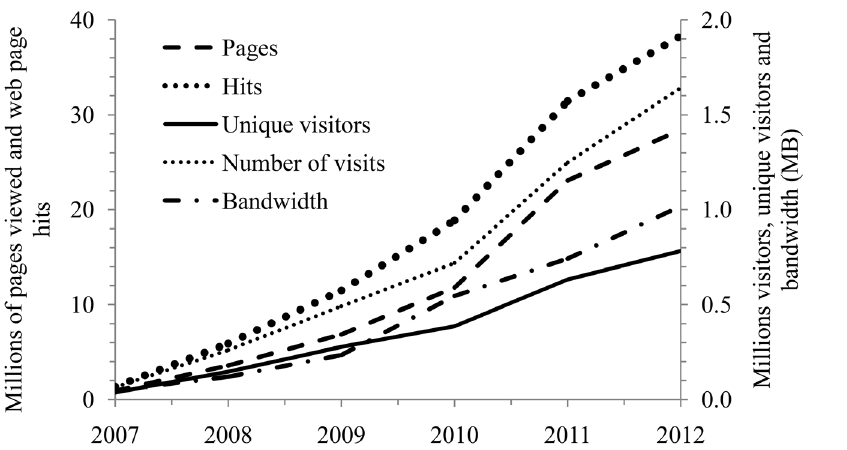
Figure 5. The annual use of the WoRMS website since January 2007 in terms of pages viewed and web page hits (left axis), and numbers of visits, unique visitors and bandwidth (MB) (right axis). The data for 2012 are estimated based on the trend until October.